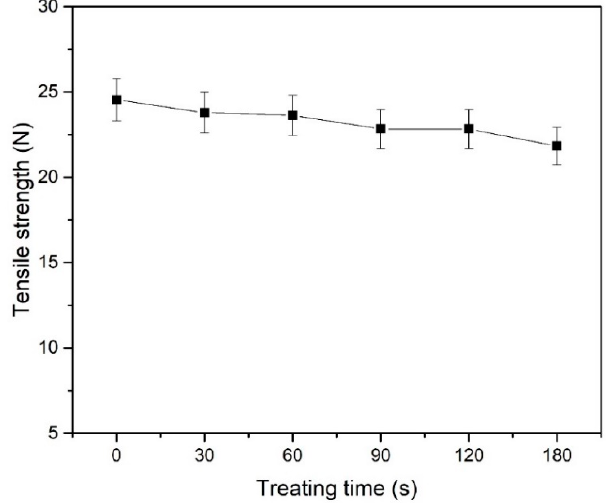
Figure 8. Influence of DBD plasma treatment duration on tensile strength.